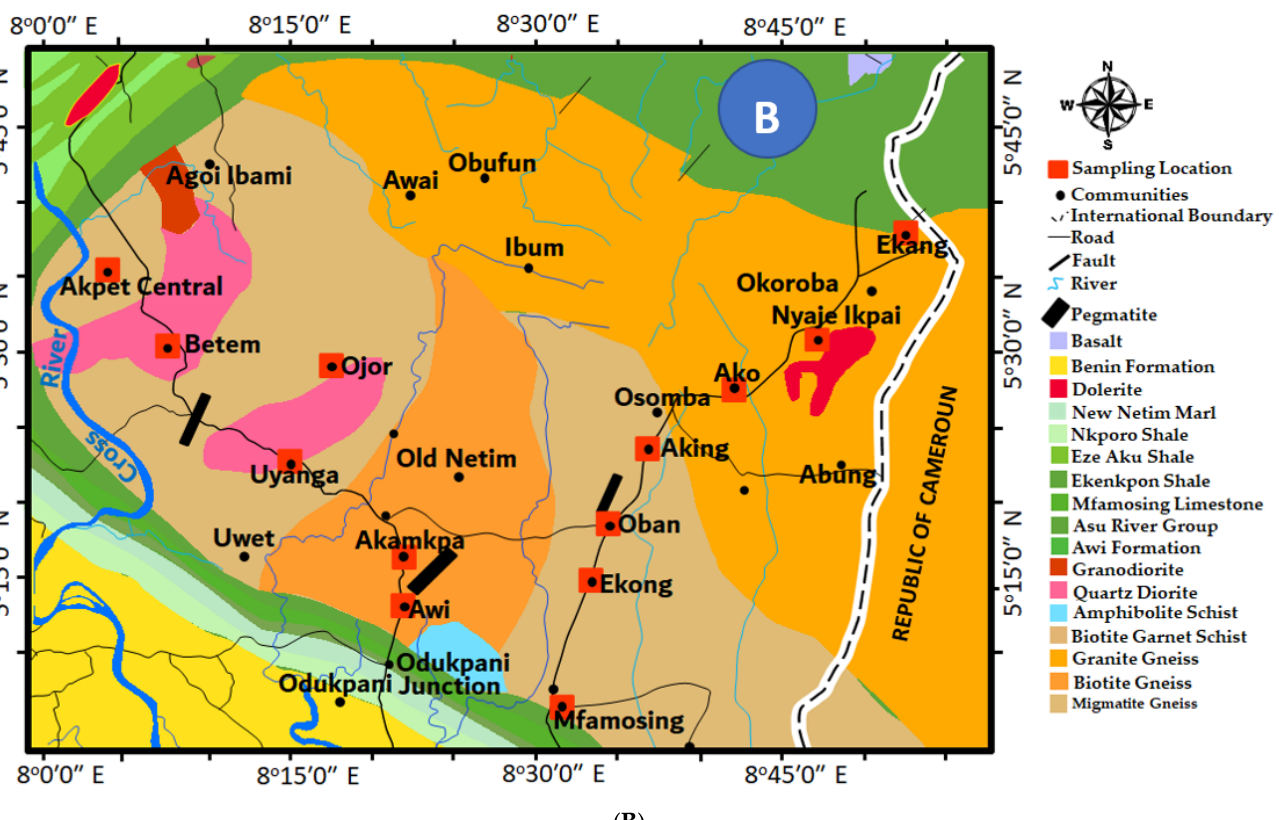
Figure 2. Map of Nigeria ( A ) showing the location of Cross River State. Insert ( B ) Generalized geological map of the study area using a cylindrical layer, made of lead to absorb X-rays generated when radiation made sudden contact with the detector. Before deploying the system for actual activity analysis, environmental radioactivity (background) counts were conducted by counting the activity of a sealed empty beaker put into the system for 12 h. The results were used to correct the net gamma peaks observed from the different isotopes using Genie 2000 computer software.